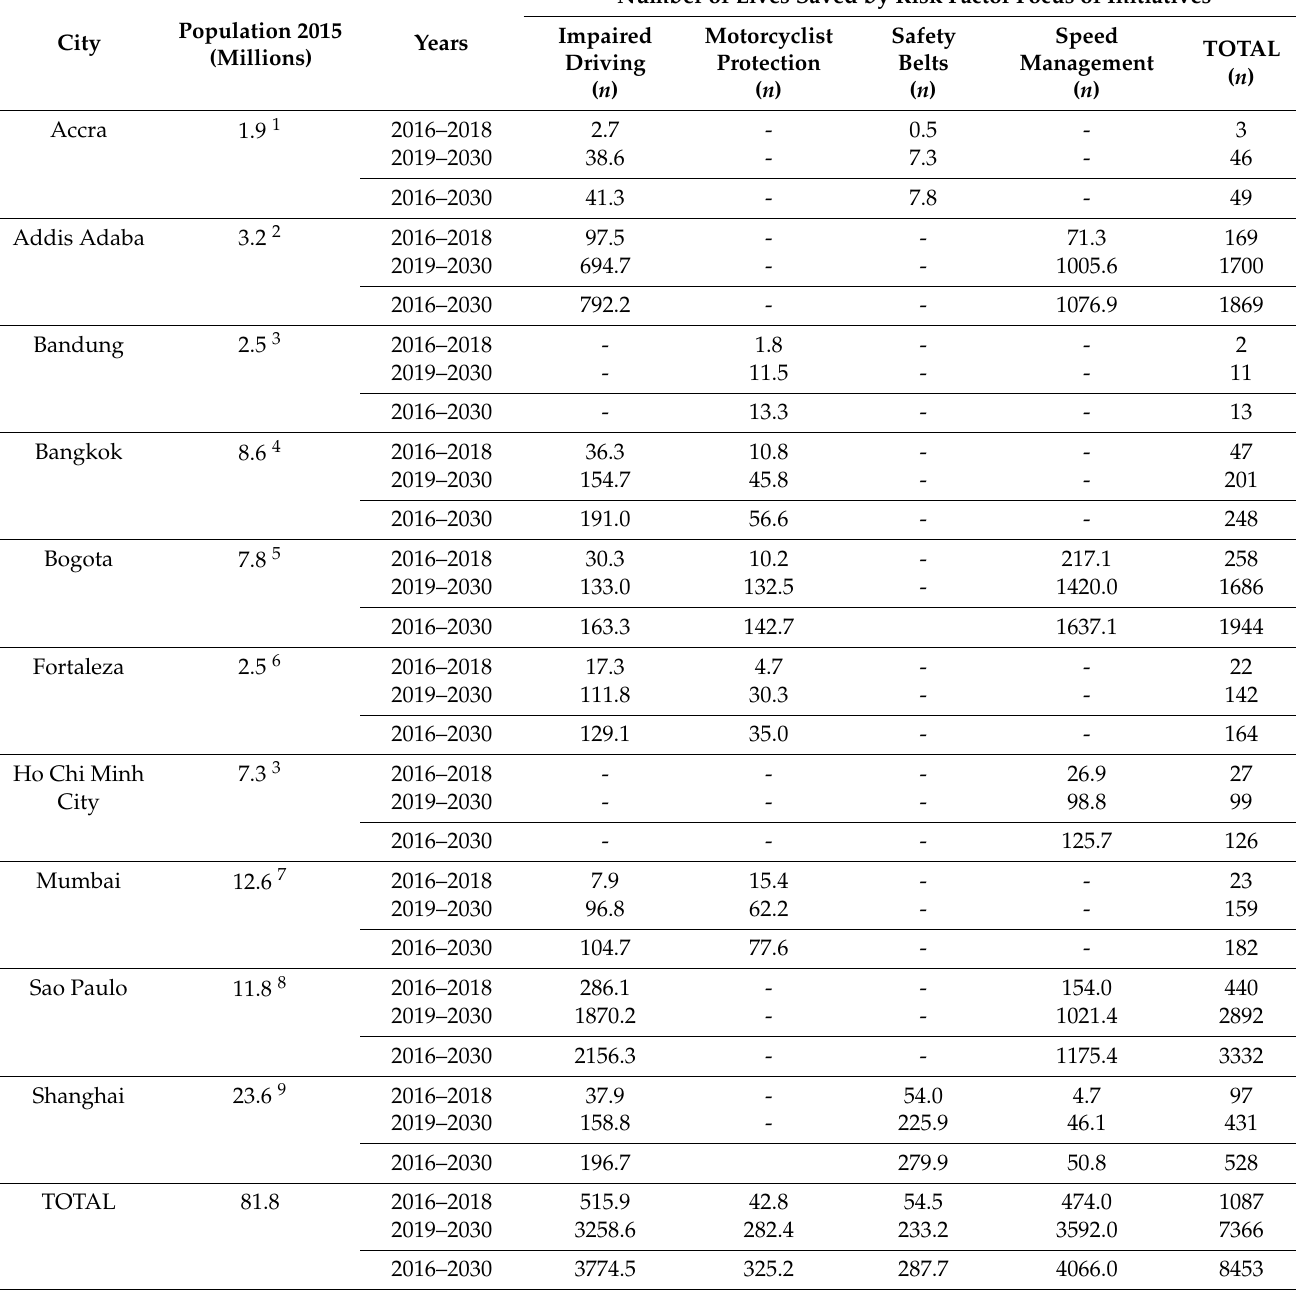
Table A4. BIGRS (2015–2019): Estimates of Lives Saved from Social Marketing Campaigns, Police Enforcement, and Related Road Safety Initiatives in the 10 Target